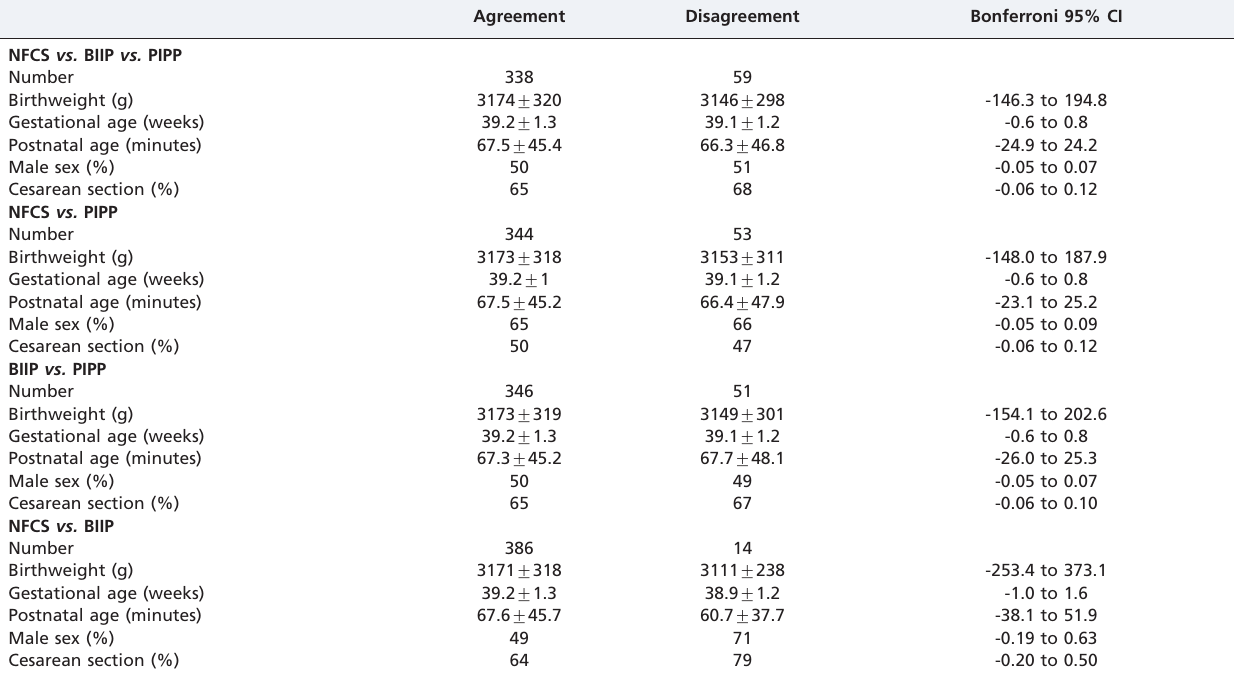
Table 3 - Characteristics of the neonates according to the agreement or disagreement between the NFCS, BIIP and PIPP scales regarding the presence of pain during vitamin K injection (T2).